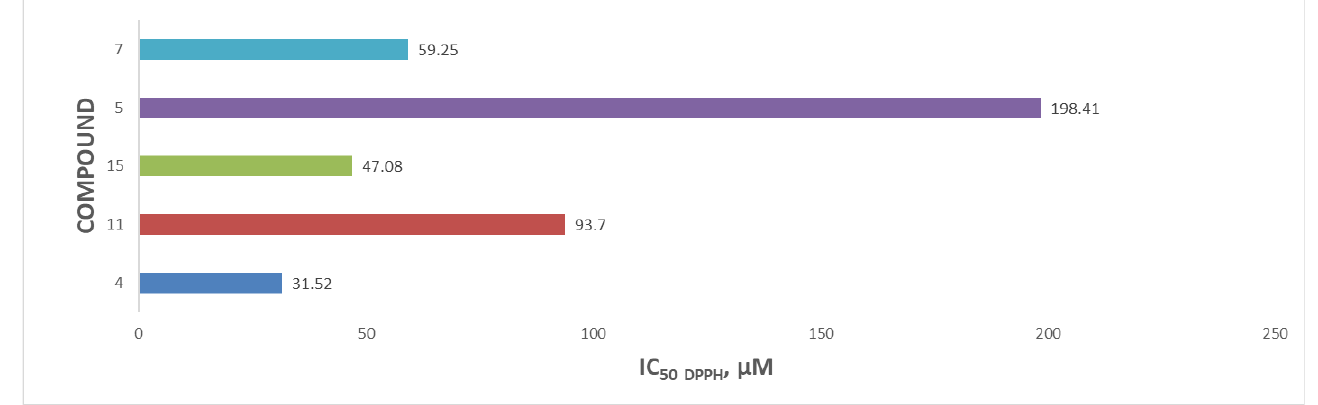
Figure 4. DPPH free radical scavenging activity of the flavonoid acetamide derivatives expressed as IC 50 values.